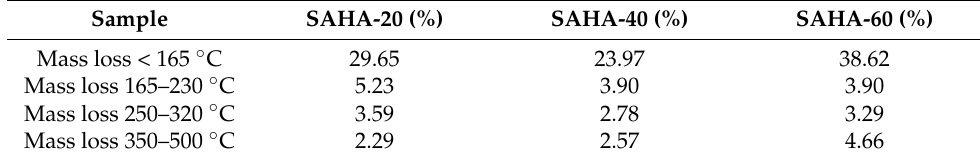
Table 2. Mass loss at different temperatures.